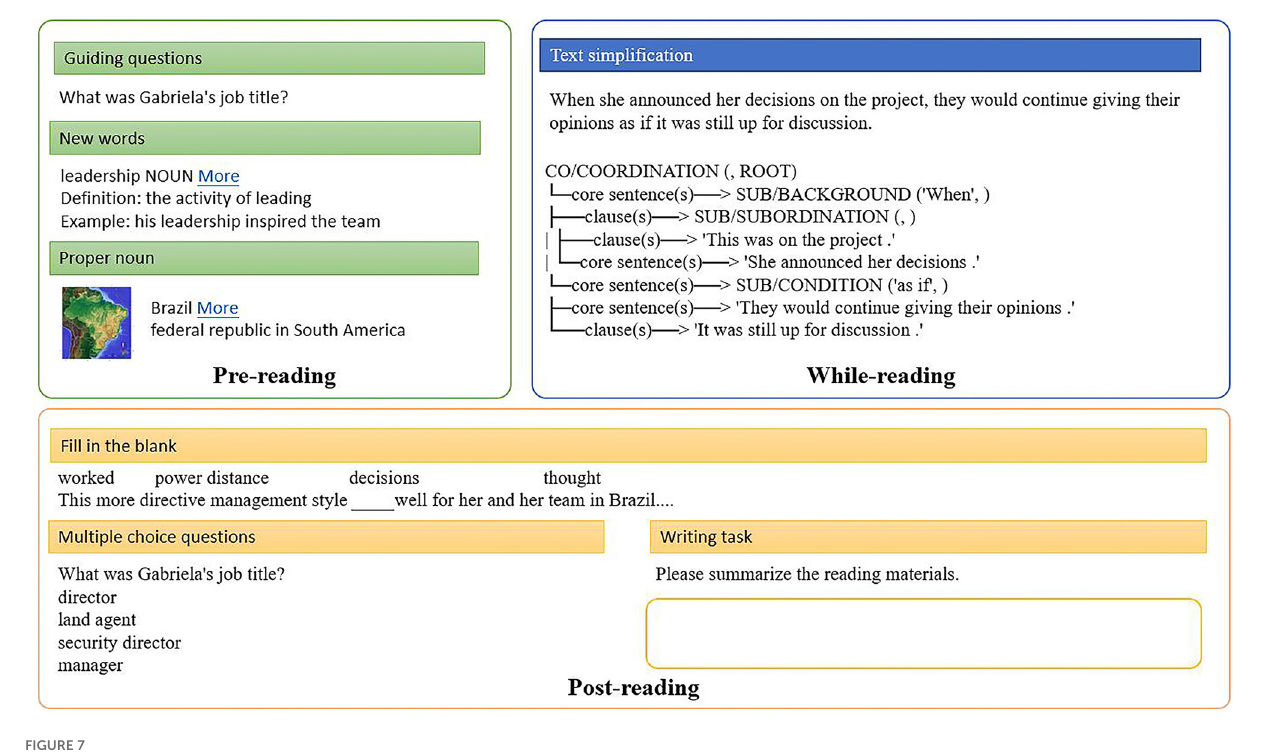
FIGURE7 Sample results in the pre-reading, while-reading, and post-reading